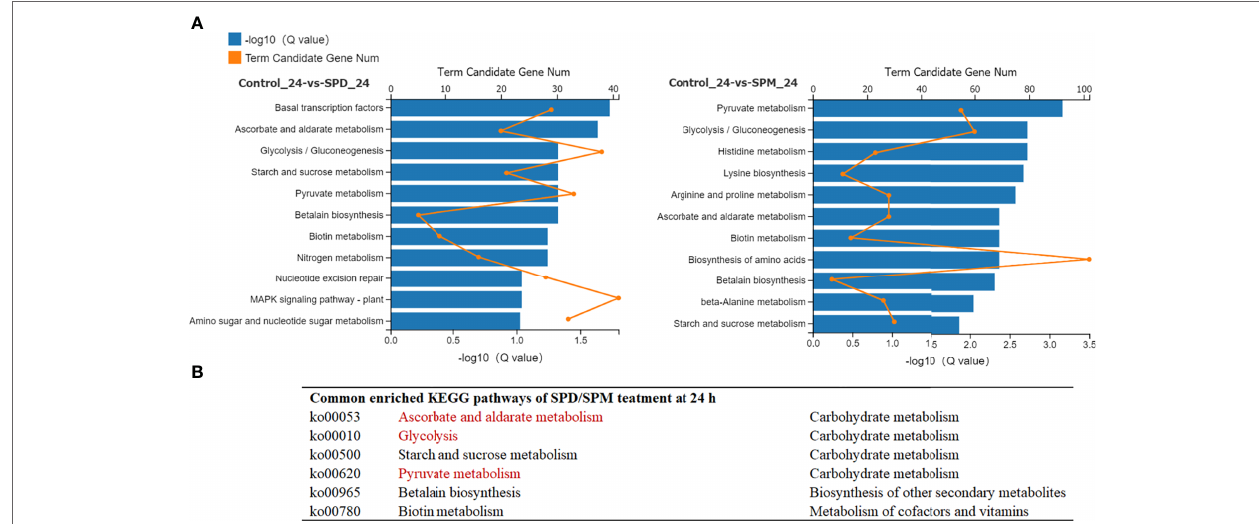
FIGURE 6 | Overview of transcriptome changes of PA-induced differentially expressed genes (DEGs) at 24 h under HT stress. (A) Enriched KEGG pathways of DEGs between the SPD (or SPM)-treated and CK groups at 24 h, respectively. (B) The common enriched KEGG pathways of SPD and SPM at 24 h, respectively. The values shown are the averages from three biological